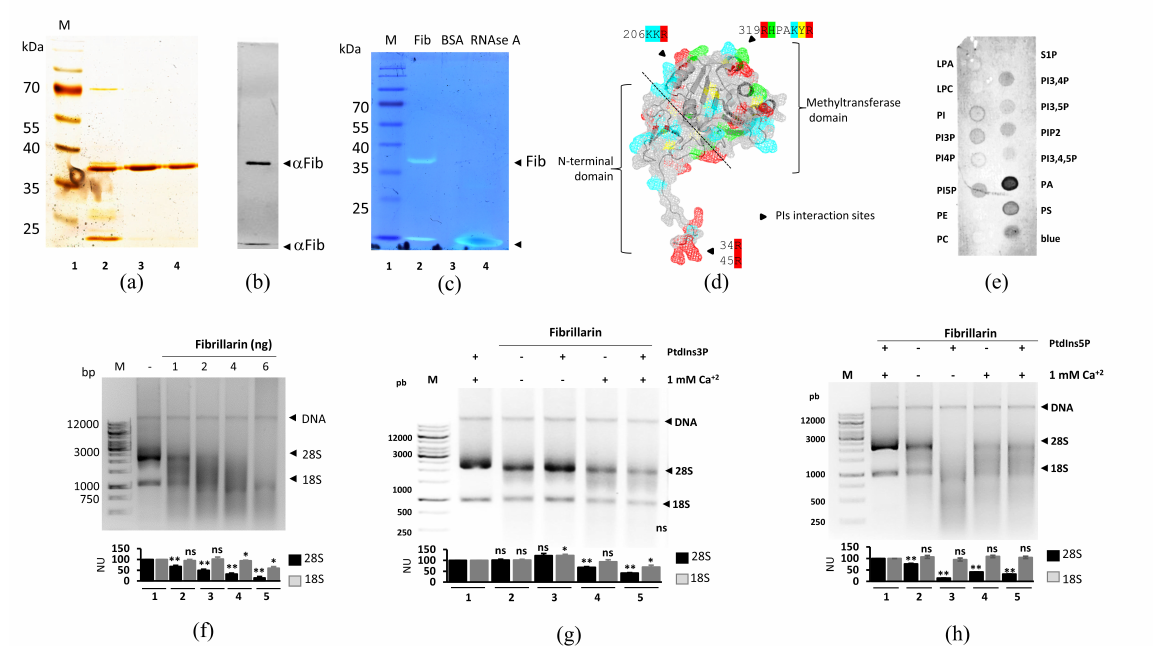
Figure 1. Fibrillarin acts as a ribonuclease. ( a ) Silver stain of purified fibrillarin. M: molecular weight marker. 2, 3, and 4: di ff erent fibrillarin elution profiles. Only elution 2 and 3 (major quality of protein purification) were used for further analysis. ( b ) Fibrillarin Western blot revealed two bands marked with arrow-heads that were recognized by specific fibrillarin antibody. ( c ) In-gel fibrillarin RNA assay shows two signals marked with arrowheads corresponding to fibrillarin (Lane 2). BSA and RNAse A were used as negative and positive controls, respectively (Lanes 3 and 4). ( d ) Computational inference of possible binding sites for phosphoinositides, one residing in the GAR domain and two in the globular C-terminal domain, are marked with arrows. The fibrillarin sequence with characteristic amino acids for phosphoinositide-binding is noted. Three to five amino acids are necessary for phophoinositide-binding [45,46]. These amino acids should be positively charged with at least one having an aromatic ring. Red: arginine, blue: lysine, green: histidine, yellow: tyrosine. ( e ) Fibrillarin fat blot assay shows that fibrillarin interacts modestly with several phosphoinositides and strongly with PA. Figure S1 depicts the quantification signals made by ImageJ software. ( f ) Total RNA in vitro assay was performed while increasing the concentration of protein (from 2 to 8 ng) added to a constant concentration of rRNA (2 µ g). Degradation of RNA is directly proportional to the amount of fibrillarin. Copurified DNA from TriZol extraction is indicated by head arrows; the rRNA populations, i.e., 28S and 18S, are indicated. Influence of PI3P ( g ) and PIP5 ( h ) on human fibrillarin in vitro ribonuclease assay. ( f – h ) Quantification of 28S and 18S signals were made by ImageJ software and represented in normalized units (NU), statistical significance was determined by t -test (* p -value < 0.05; ** p -value < 0.01; *** p -value < 0.001, ns = not significant p -value > 0.05) and plots are indicated below the gels from n =